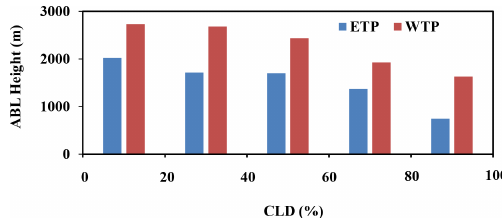
Figure 12. The mean ABLH (for the NBL and CBL) and CLD over the ETP (blue) and WTP (red) in the daytime (14:00 and